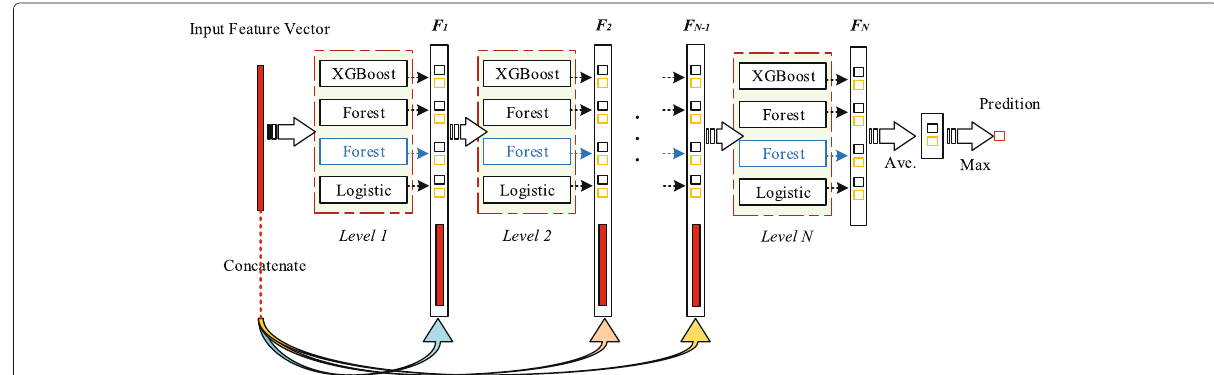
Fig. 2 The cascade-forest structure. Suppose we have two classes that need to be predicted. Consider there are four different ensemble algorithms. Black and blue are random forest and completely random forest, respectively. Each level of the cascade forest is an ensemble of distinctive classification algorithms. Each algorithm will generate a prediction of the distribution of classes. The final prediction is obtained by layer-by-layer